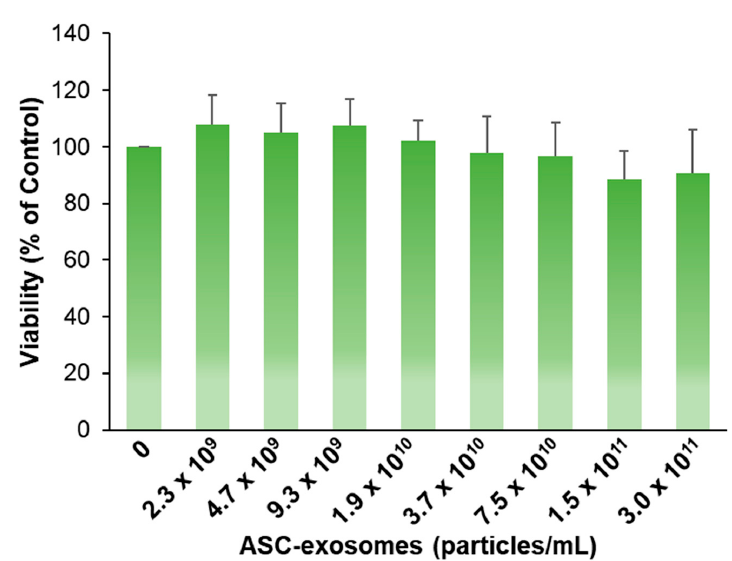
Figure 2. No cytotoxicity of ASC-exosomes on B16F10 melanoma cells. The cytotoxic effect of ASC-exosomes was determined by measuring cell viability after incubation of the cells with increasing concentrations of ASC-exosomes for 72 h. Data are presented as the mean ± SD performed in triplicate. Second, the effects of ASC-CM and ASC-exosomes on the production of melanin in B16F10 cells were studied in the absence of α -MSH. ASC-CM reduced the concentration of intracellular melanin in a dose-dependent fashion (Figure 3A). ASC-exosomes also reduced the levels of intracellular melanin in B16F10 cells, and this effect saturated at a concentration of 1.5 × 10 11 particles/mL. These results suggest that ASC-exosomes negatively regulate intracellular melanin in B16F10 cells in the absence of α -MSH.